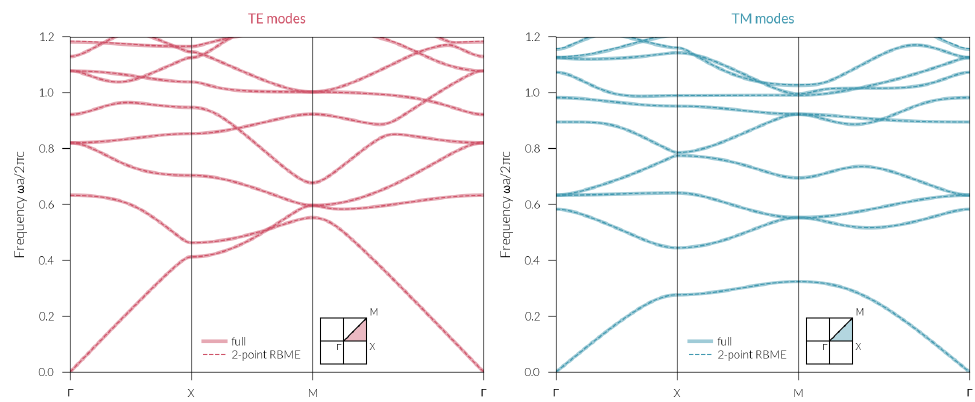
Figure A3. The photonic band structure for a square array of dielectric columns. The insets show the Brillouin zone, with the irreducible zone shaded. Solid lines are results from the full model and dashed lines are results obtained with the reduced Bloch mode expansion. Here we retained 385 plane waves in the expansion and used the first 8 modes calculated at the three symmetry points Γ , X , and M for the RBME. The path in reciprocal space is discretized with 144